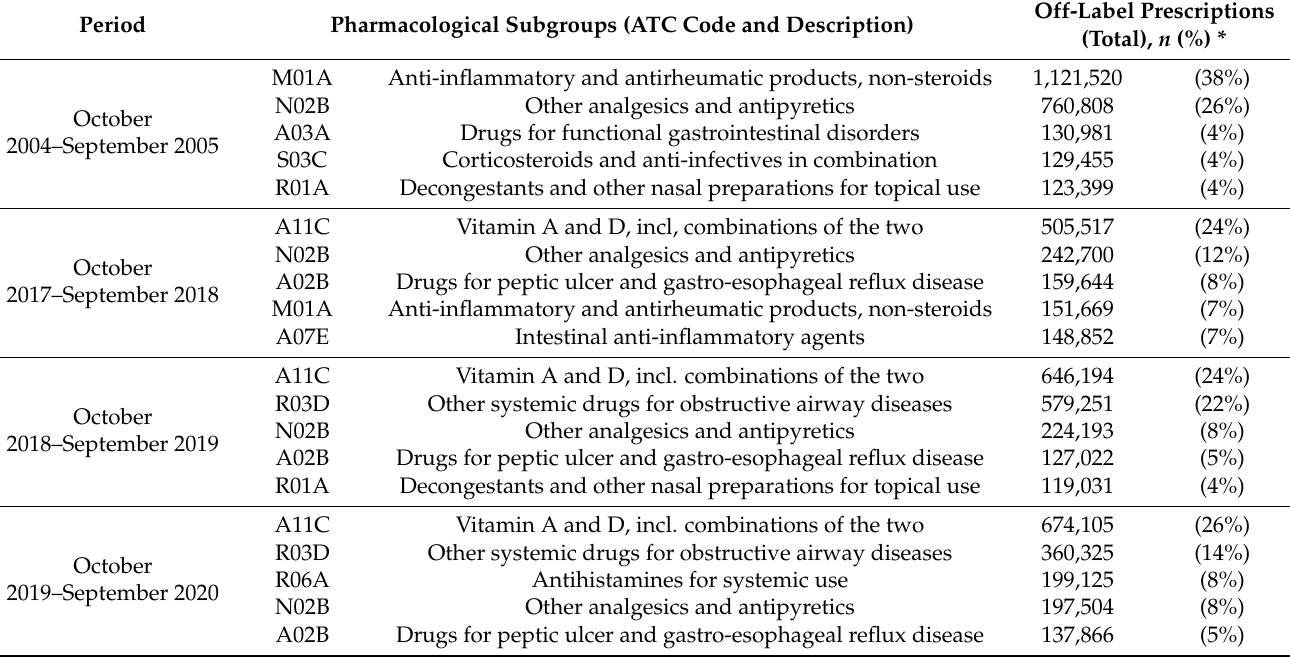
Table 5. Number of off-label prescriptions in the top 5 most-prescribed pharmacological subgroups per study period in the under-18